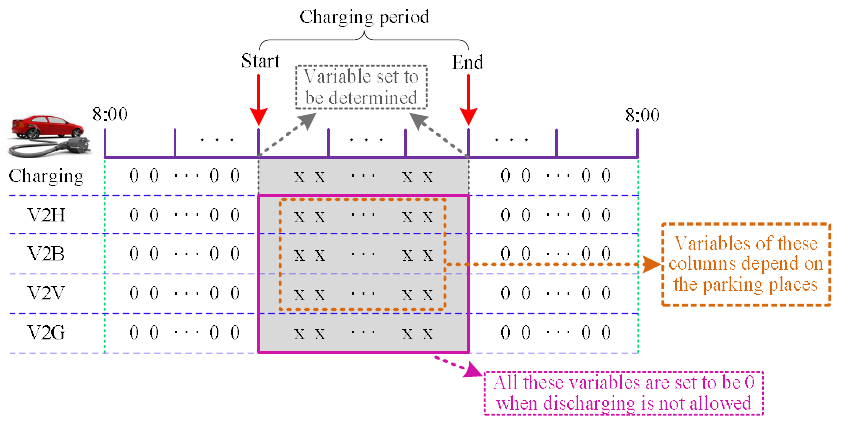
Figure 6. Treatment for control variables of a single EV.